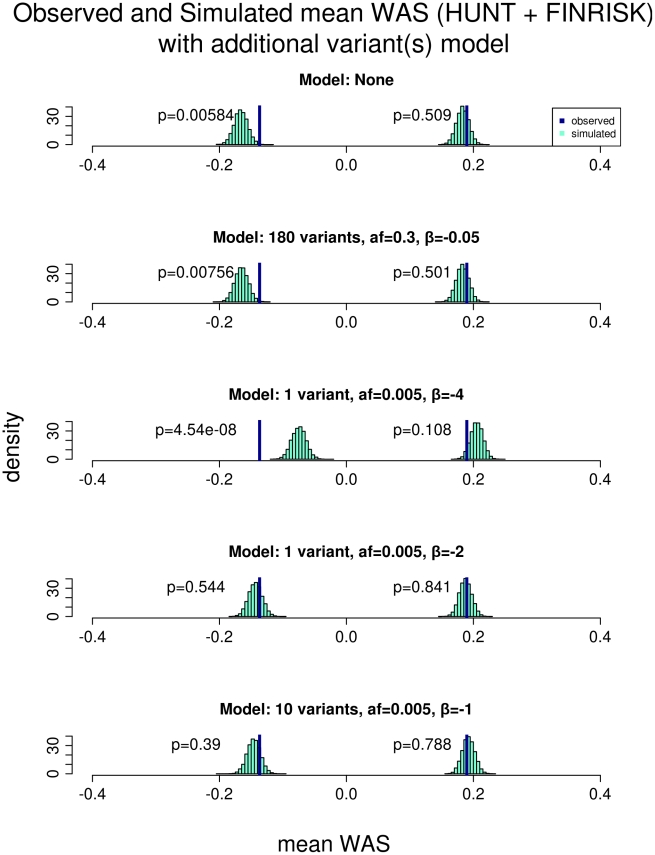
Comparison of the observed versus simulated mean WAS with models incorporating additional variants.The plot shows the result of comparing the mean WAS of the short and tall individuals observed from both the HUNT and FINRISK cohorts against that obtained from simulation with different scenarios of additional variants. All rows use the approximate 1.5% tails of the height distribution as extremes, resulting in 566 short and 648 tall individuals. The 1st row shows the result where the model has no additional variants affecting height and thus is identical to that from the 2nd row of Figure 2. The 2nd row shows a model where there are 180 additional common variants that slightly decreases height (allele frequency = 0.3 and effect size (β) = −0.05). This model does not result in any significant change to the simulated WAS of the short individuals and the observed WAS is still significantly different (p = 0.00756). The 3rd row shows a model where there is 1 additional low frequency variant with a large height decreasing effect (allele frequency = 0.005 and effect size (β) = −4). This model results in a large shift in the simulated WAS of the short individuals to the right. The observed WAS is still significantly different (p = 4.54×10−8) than the simulation but in the opposite direction and thus is not consistent with our data. The 4th row shows a model where there is 1 additional low frequency variant that decreases height significantly (allele frequency = 0.005 and effect size (β) = −2). This model results in a shift in the simulated WAS of the short individuals to the right such that the observed WAS is no longer different from the simulation (p = 0.544). The 5th row shows a model where there are 10 additional low frequency variants that moderately decreases height (allele frequency = 0.005 and effect size (β) = −1). This model also results in a shift in the simulated WAS of the short individuals to the right such that the observed WAS is no longer different from the simulation (p = 0.39). The final two models are consistent with our observed data.